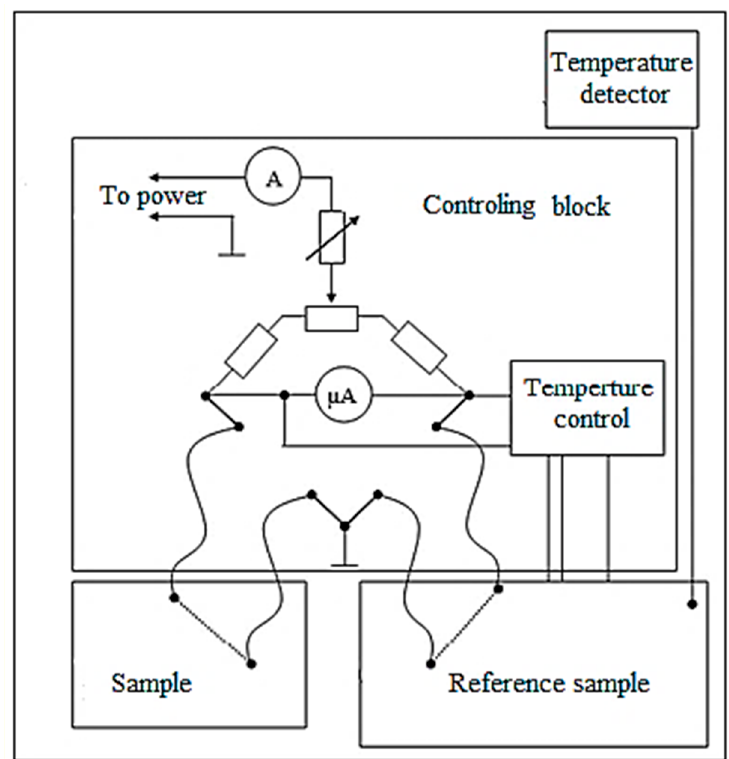
Figure 1. Schematic diagram of a setup for current annealing with remote temperature control.